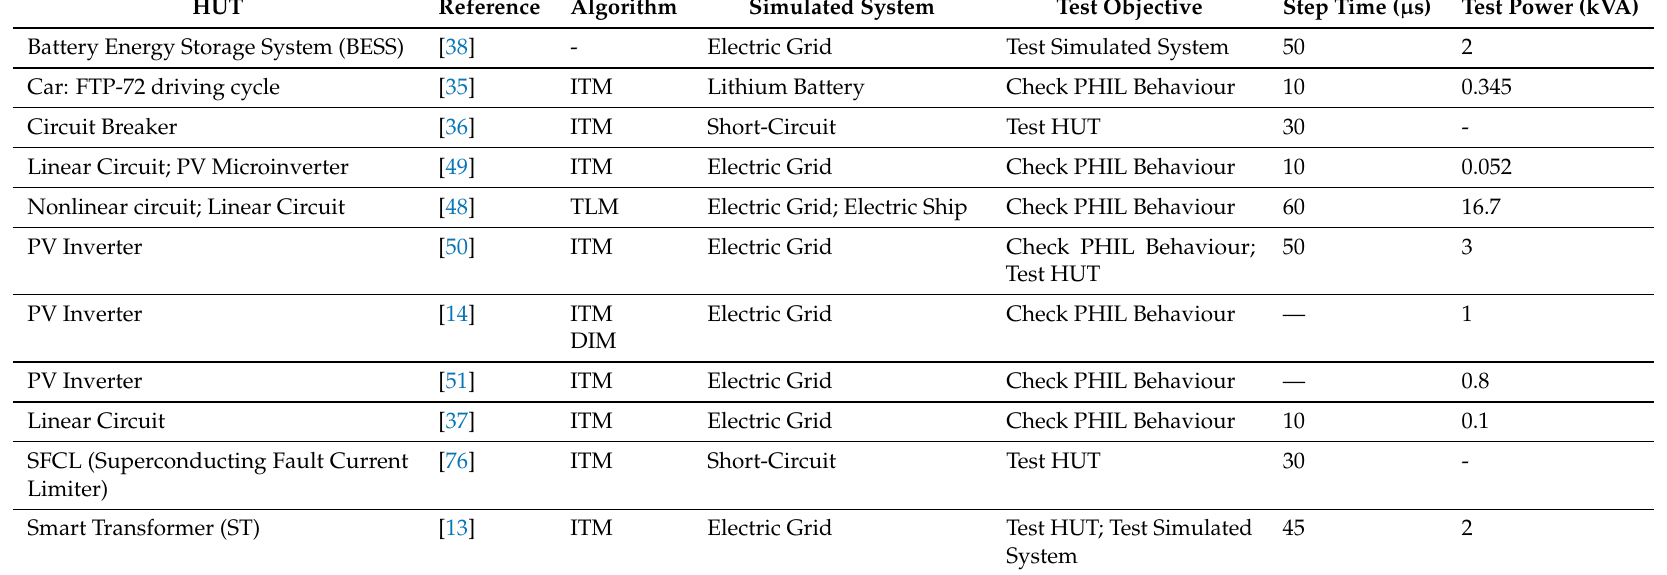
Table 3. Database classification according the type of HUT used in the PHIL